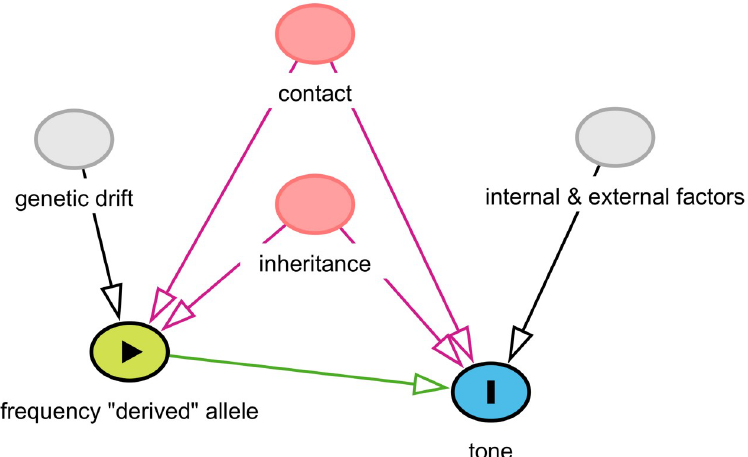
Fig 4. Simplified model of the causal and spurious relationships between the frequency of the “derived” alleles (the exposure ) and tone (the outcome ) using Directed Acyclic Graphs (DAGs). The arrows represent direct causal effect; the grey nodes are unmeasured